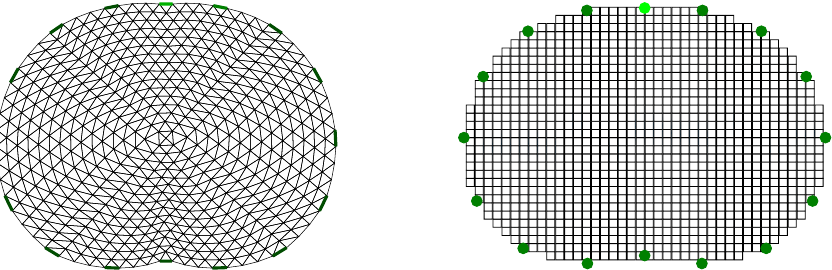
Figure 6. Reconstruction domain Ω used for the EIT imaging. Left : F.E. mesh. Right : MoM